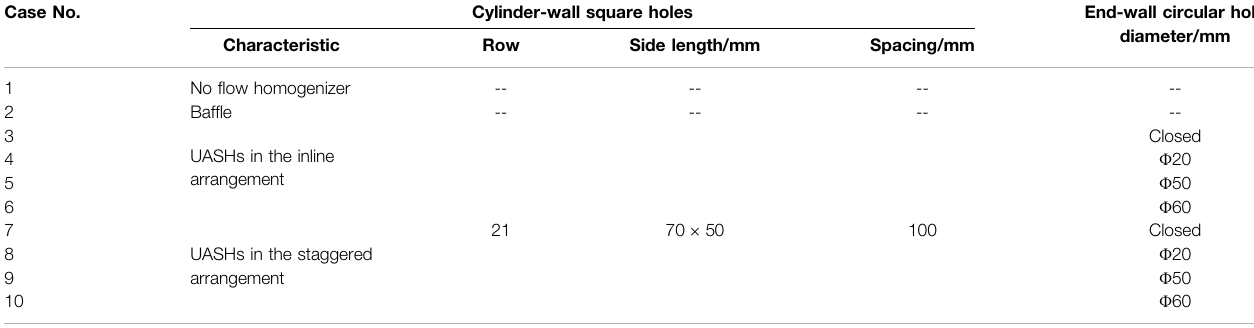
TABLE 3 | Characteristic geometrical parameters of hot helium fl ow homogenizers with UASHs. Case No.